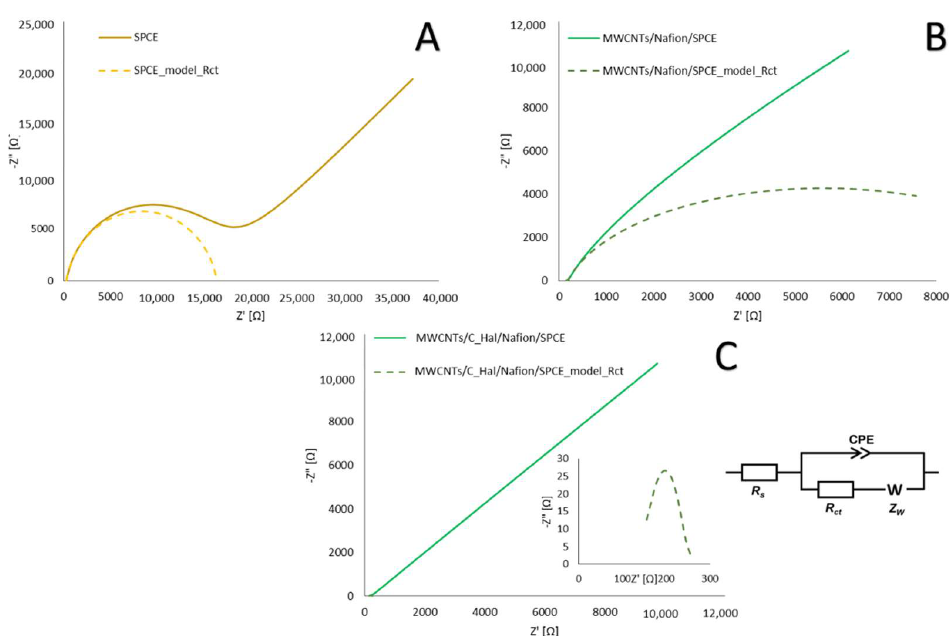
Figure 5. The impedance spectra recorded for [Fe(CN) 6 ] 3 −\ 4 − (0.5 mmol L − 1 ) in 1 mol L − 1 KCl solution for ( A ) unmodified SPCE, ( B ) MWCNTs/Nafion/SPCE, ( C ) MWCNTs/C_Hal/Nafion/SPCE and model semicircle with the equivalent circuit diagram.